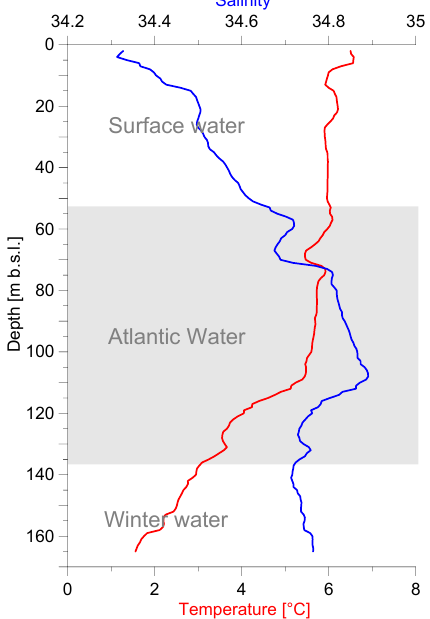
Figure 2. Temperature and salinity against depth (in metres below sea level, mb.s.l.) at station MSM02/03-666-3 (same location as the studied sediment core GeoB10817-4; see Sect. 3) derived during cruise MSM02/03 applying a Sea-Bird CTD sensor as described in the cruise report (Lherminier et al., 2009). The profile illustrates subsurface Atlantic Water inflow at the core site (grey shading), framed by less saline surface water on top and colder winter water at the bottom. Winter water forms locally by convection processes during autumn–winter (Cottier et al., 2010). Temperature (>3 ◦ C) and salinity boundaries (>34.65) following Cottier et al.